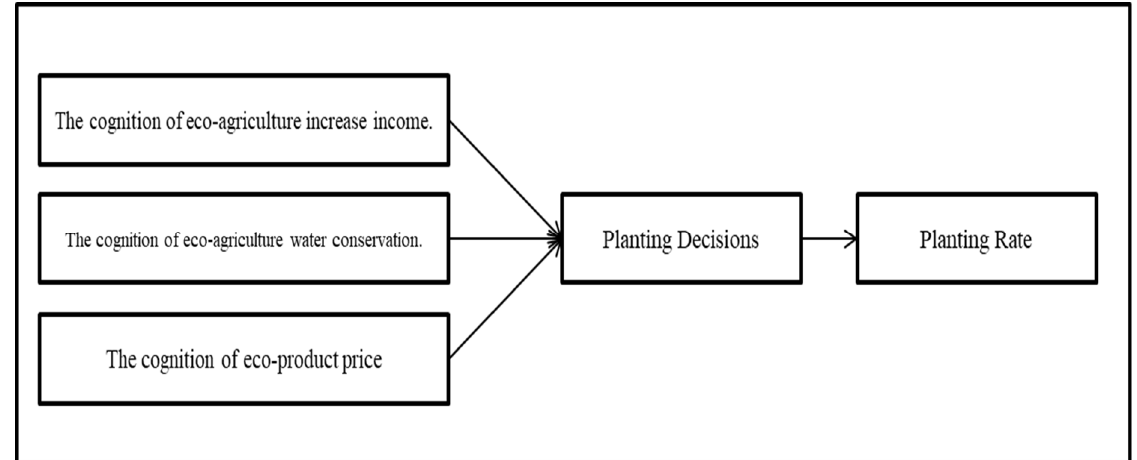
Figure 1. Conceptual framework of ecological cognition and response to specialty orchard fruit planting.